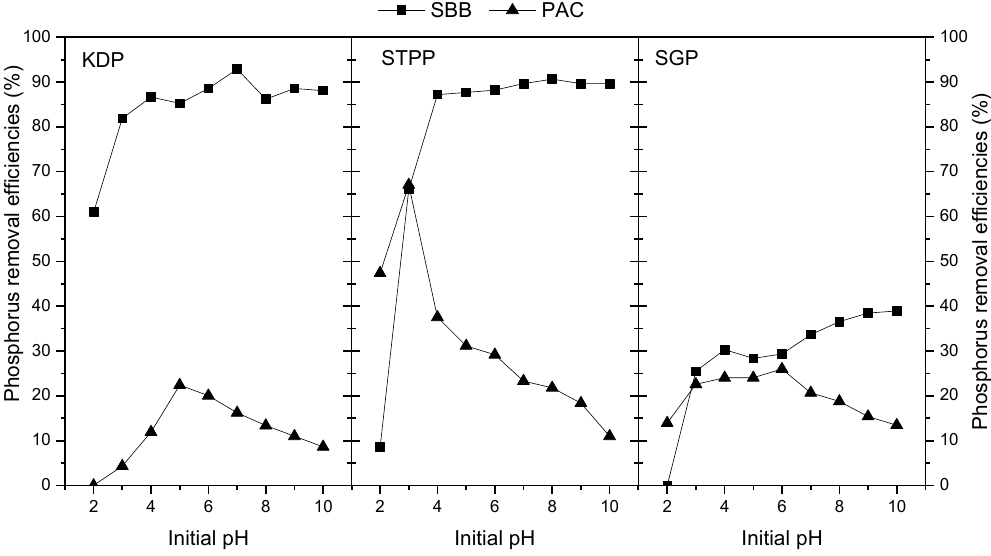
Figure 2. Effect of initial pH on the removal of phosphates on SBB and PAC (Phosphate concentration: 20 mg·L − 1 ; adsorbent dosage: 3 g·L − 1 ; contact time: 2 h (KDP), 1 h (STPP), 0.5 h (SGP); shaking rate: 120 20 mg · L − 1 ; adsorbent dosage: 3 g · L − 1 ; contact time: 2 h (KDP), 1 h (STPP), 0.5 h (SGP); shaking rate: rpm). 120